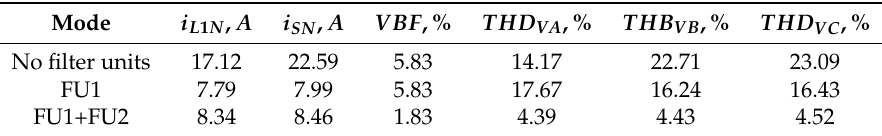
Table 2. Simulation